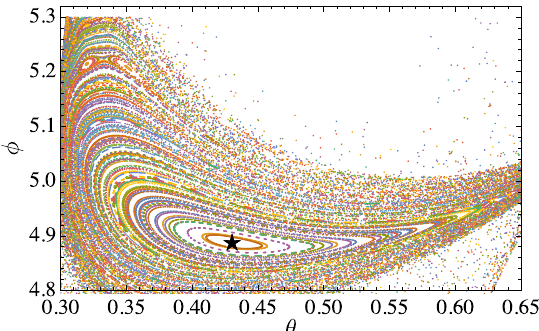
FIG. 12. The projection of the Poincar´e section onto the ( θ ; ϕ ) plane in the vicinity of the periodic orbit reveals a regular region of phase space.